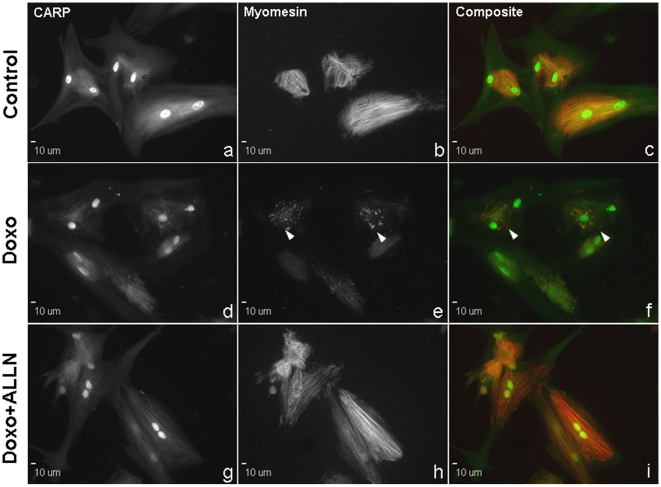
Calpain inhibition preserves sarcomere structure but not CARP levels in ARVMs treated with doxorubicin.
A: Immunofluorescent images of untreated ARVMs (a–c) or ARVMs treated for 24 h with 1 µM doxorubicin (Doxo, d–f) in the presence or absence of 100 µM N-acetyl-L-leucyl-norleucinal (ALLN, g–i). ARVMs were co-stained for CARP (green) and myomesin (red); arrowheads indicate presence of dense myomesin aggregates.